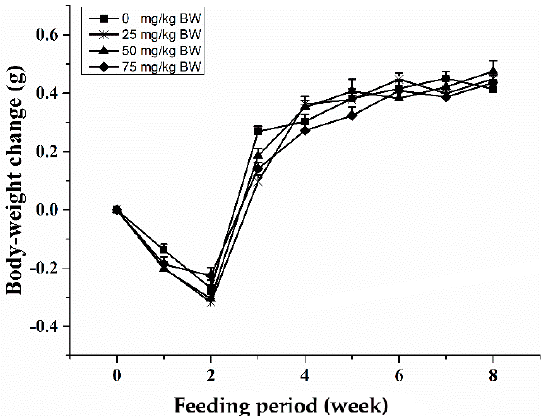
Figure 1. Body-weight change of C57BL/6 mice treated with oral administration of sea cucumber polypeptides (SCP). Mice received daily oral gavage of SCP at 0, 25, 50 or 75 mg/kg body weight for eight weeks. Values are means ± SD, n = 10. There was no a significant between control group and SCP group by repeated measures ANOVA ( p < 0.05). BW, body weight.